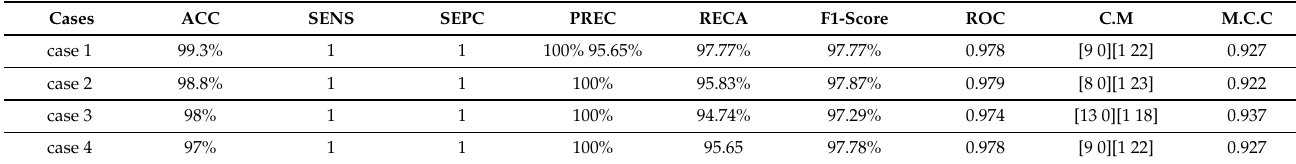
Table 9. Four cases for data set